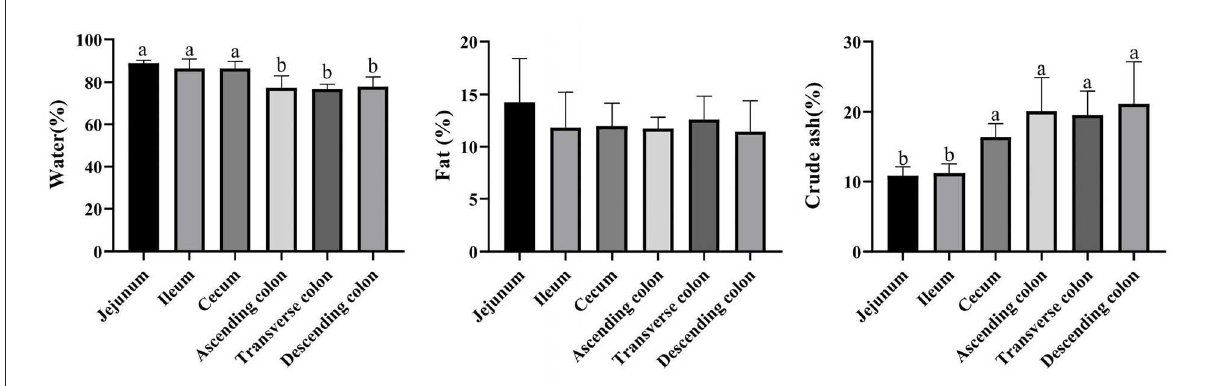
FIGURE7 Concentrations of moisture, fat, and crude ash in different intestinal locations of pigs. The concentration of fat and crude ash was based on the dry matter of the intestinal contents. Data are shown as mean ± SD ( n = 6). The same letter within each column indicates no significant difference ( p > 0.05).